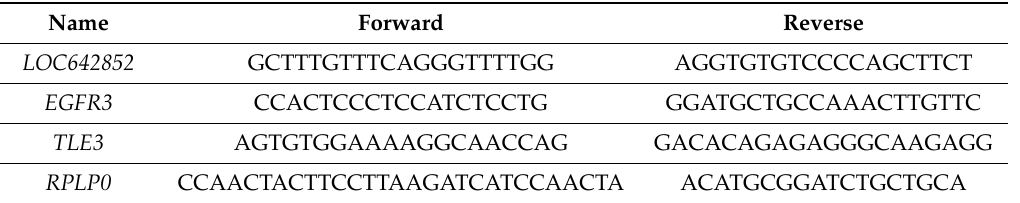
Table 3. qRT-PCR primer sequences.